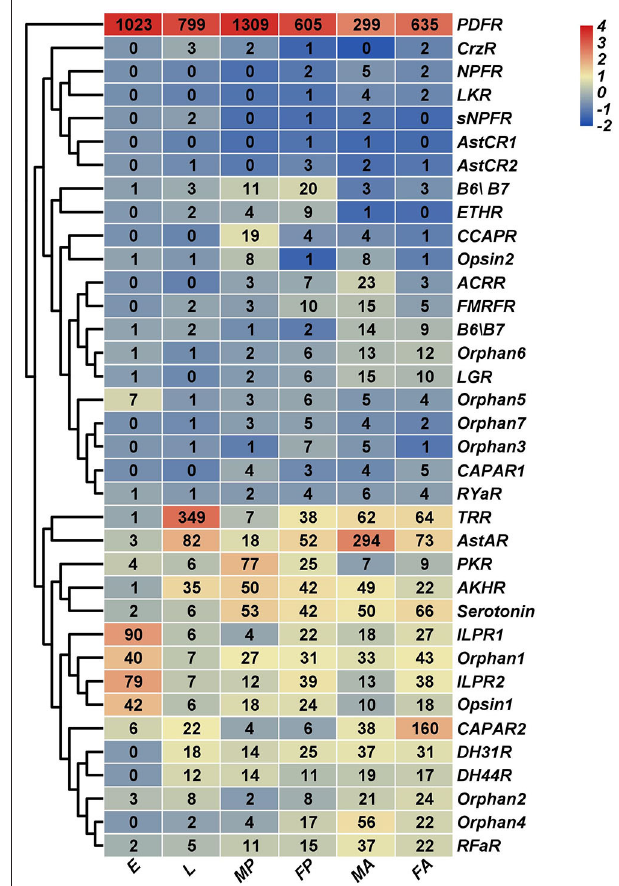
FIGURE 10 | Expression profiles of H. hebetor neuropeptide receptor genes across different developmental stages. Log2 FPKM (fragments per kilobase of transcript per million) values for neuropeptide precursor genes are presented by bar colors where darker red represents higher expression values, and darker navy blue represents lower expression values. FA, female adults; MA, male adults; E, eggs; L, larvae; FP, female pupae; MP, male